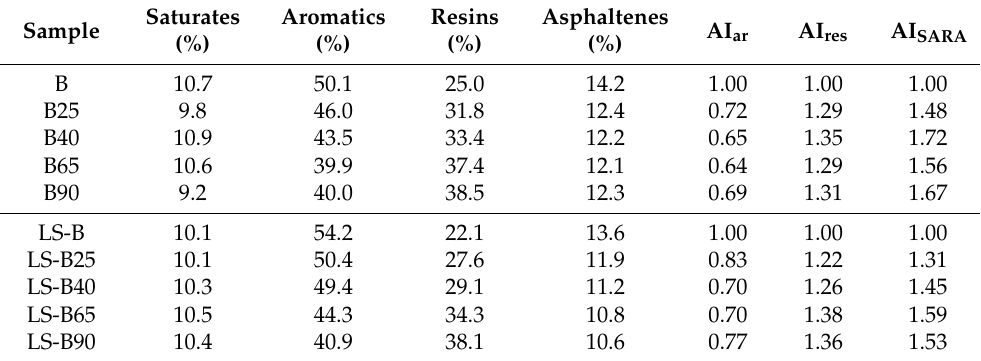
Table 6. SARA fractions from